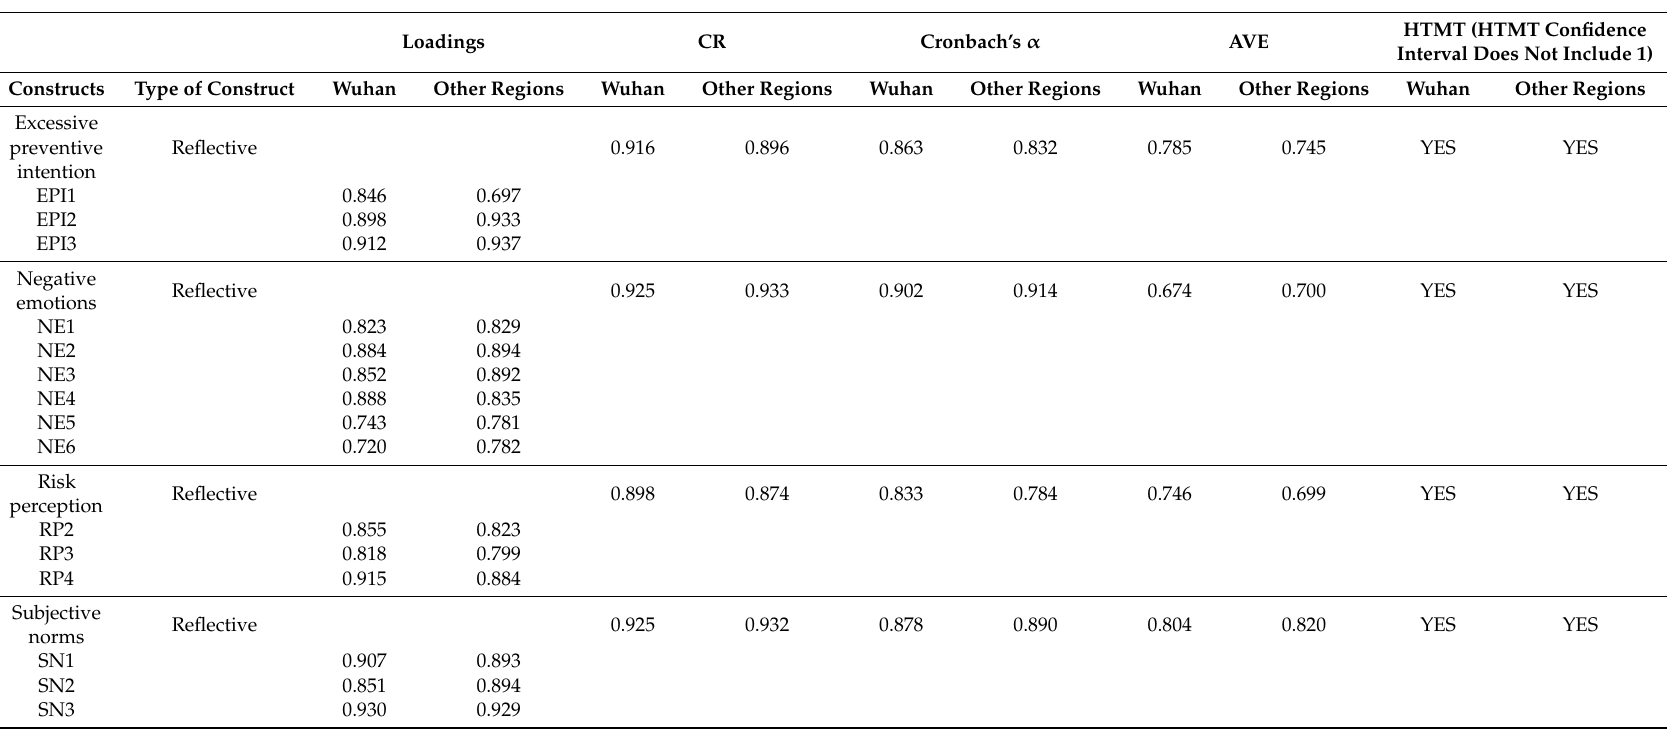
Table 4. Results for reflective measurement